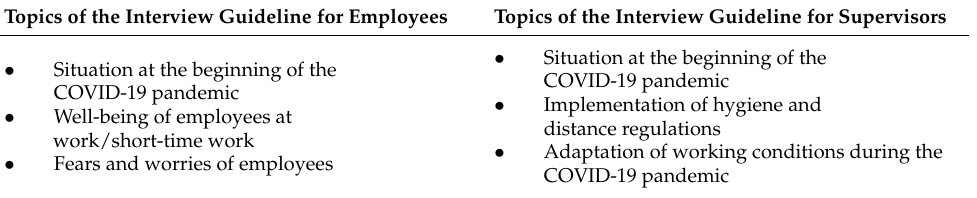
Table 1. Topics of the interview guideline for employees and supervisors of social firms. Topics of the Interview Guideline for Employees Topics of the Interview Guideline for